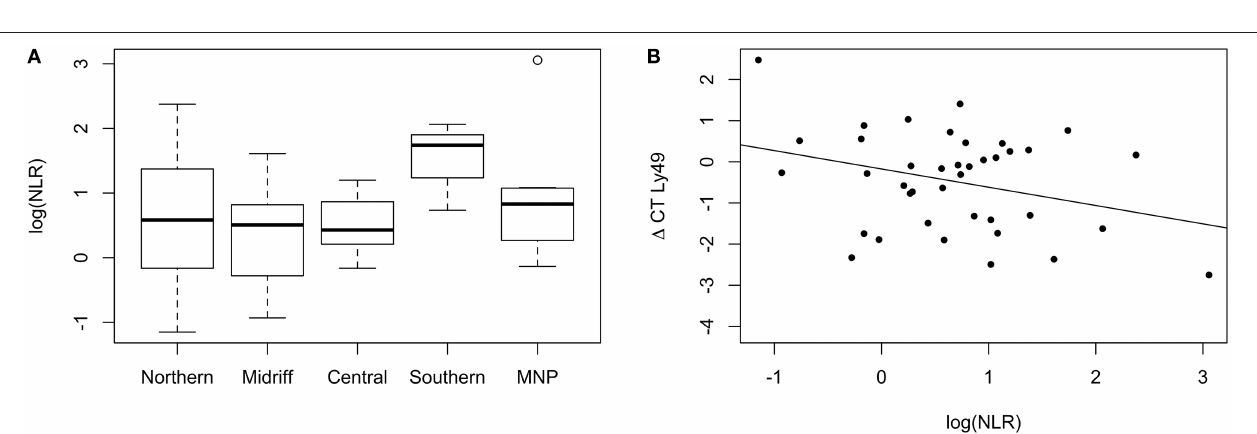
FIGURE 7 | Gene transcription levels varied according to genital infection status. (A) Eomes , (B) Perforin , (C) Tbx21 , (D) Granzyme. The plot shows the median (thick line), first and third quartile (box), and 95% confidence interval of the median (whiskers).